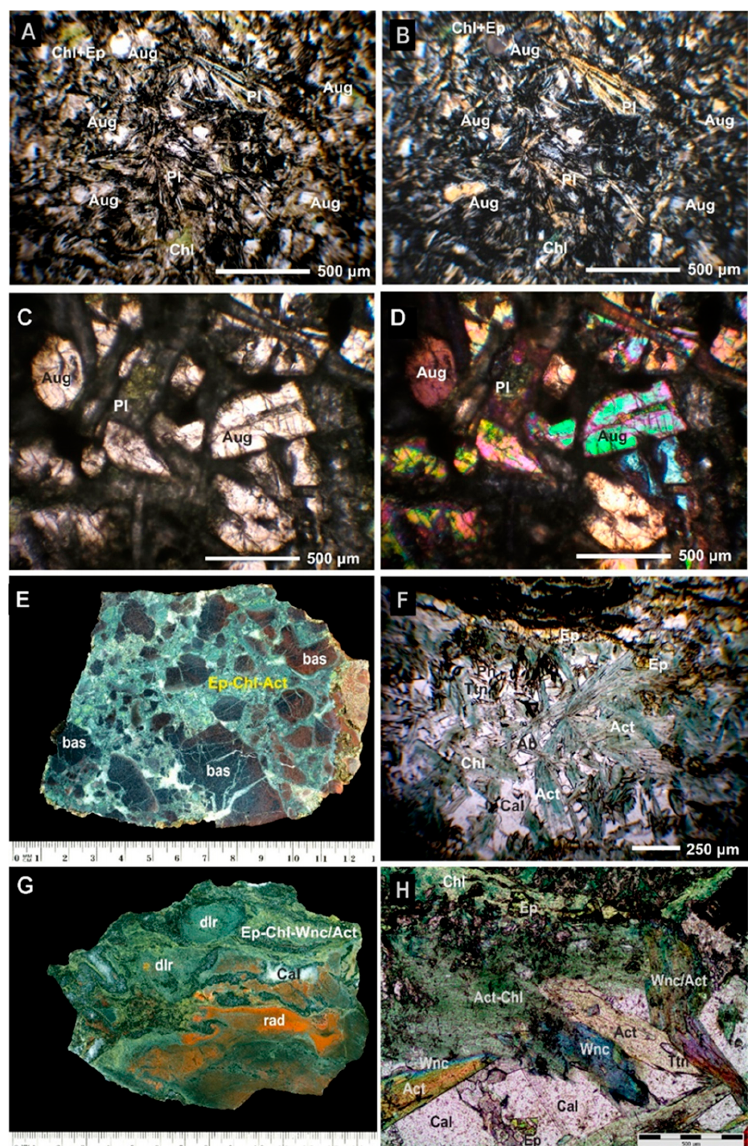
Figure 7. Images of the Jaklovce Unit metabasalt and metadolerite textures: ( A , B ) metabasalt (s. JAK-30) with a relic ophitic texture of Cpx and radially distributed albitised Pl. Clinopyroxene (Aug) is partly replaced by Chl and Ep; ( C , D ) Metadolerite (s. JAK-6B) with a relic ophitic texture of Cpx and albitised Pl; ( E ) metabasalt breccia (s. JAK-5/19) composed of dark metabasalt (bas) fragments enclosed in a greenish metamorphic matrix (Act, Chl, Ep/Czo, Ab, Cal, Ttn); ( F ) metamorphic veinlet in metabasalt (s. JAK-5/19) composed of blue-green Act, Chl, Ep, Ab, Ph, Cal and Ttn; ( G ) fragment of metadolerite (dlr, s. J-6) enclosing reddish metaradiolarite (rad) in a metamorphic matrix of Wnc/Act, Chl, Ep, Cal and Ab; and ( H ) metamorphic veinlet in metadolerite (s. J-6) is composed of Wnc/Act, Chl, Ep, Ab, Cal and Ttn. Pictures A, C, F and H at II N; B and D at X N.